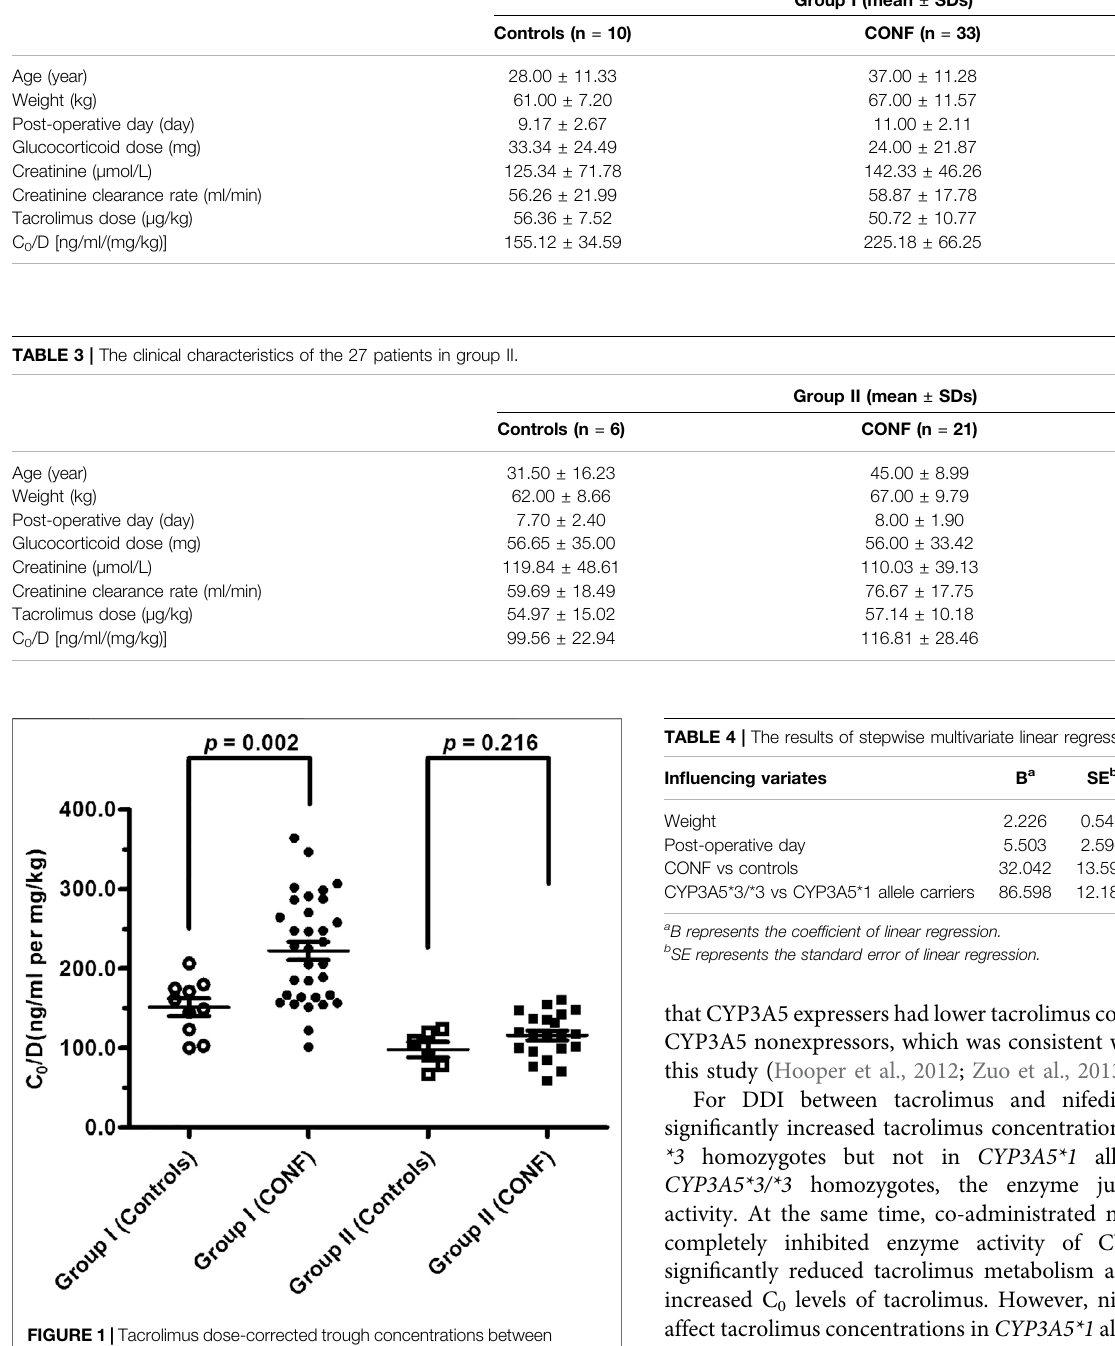
FIGURE 1 | Tacrolimus dose-corrected trough concentrations between subgroups CONF and Controls in group I and II, respectively ( p < 0.05 denotes a signi fi cant difference between corresponding data).